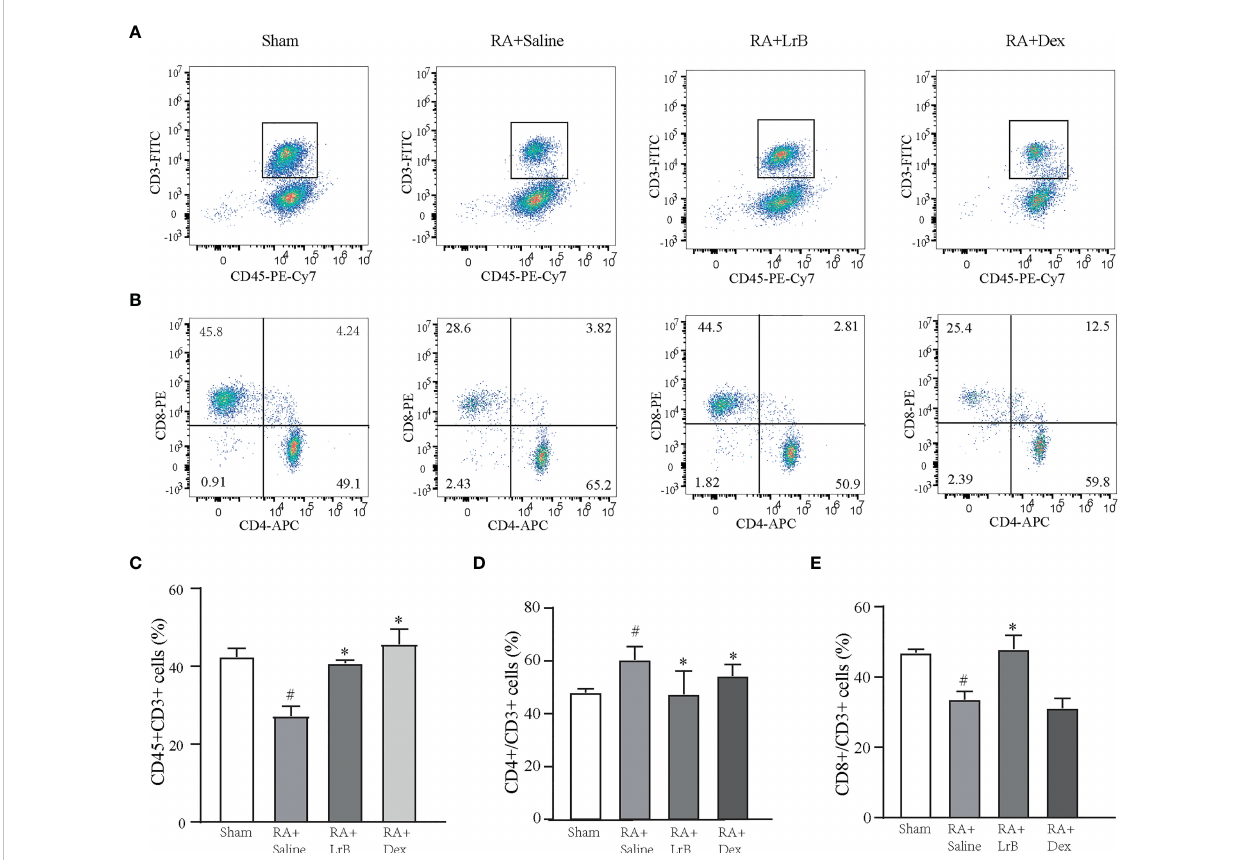
FIGURE 4 LrB changed the ratio of spleen cells in CIA rats. (A) Scatter diagram of CD45+CD3+ T-cell subtype in spleen cells of Sham and CIA rats with different treatments. (B) Scatter diagram of CD4+ and CD8+ T-cell subtypes in CD45+CD3+ T cells of CIA rats. (D) The proportion of CD4+ T-cell subtype in CD45+CD3+ T cells. (E) The proportion of CD8+ T-cell subtype in CD45+CD3+ T cells. (Results are expressed as the mean ± SEM, and tested with One Way ANOVA. # P ≤ 0.05, compared to the Sham group; * P ≤ 0.05, compared to the RA+Saline group). (C) The proportions of CD45+CD3+ T cells in total spleen